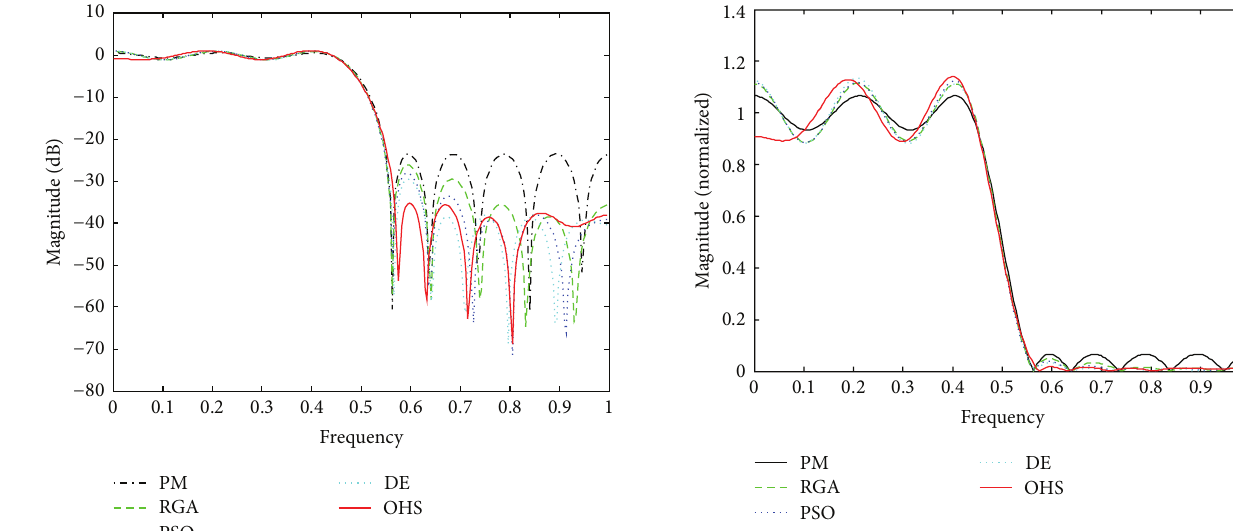
Figure 1: dB plots for the FIR LP filter of order 20.